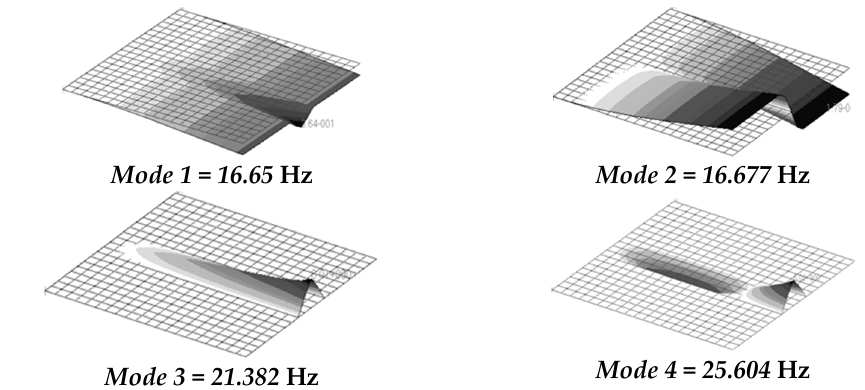
Figure 3. The first four order mode shape of the initial model.